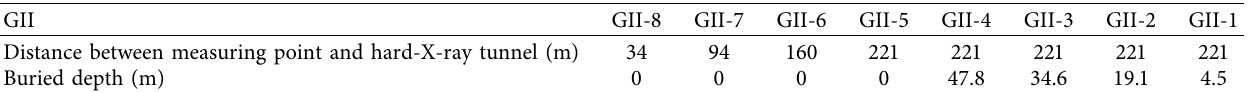
Table 2: Positions of measurement points in the second group of measurements. GII Distance between measuring point and hard-X-ray tunnel